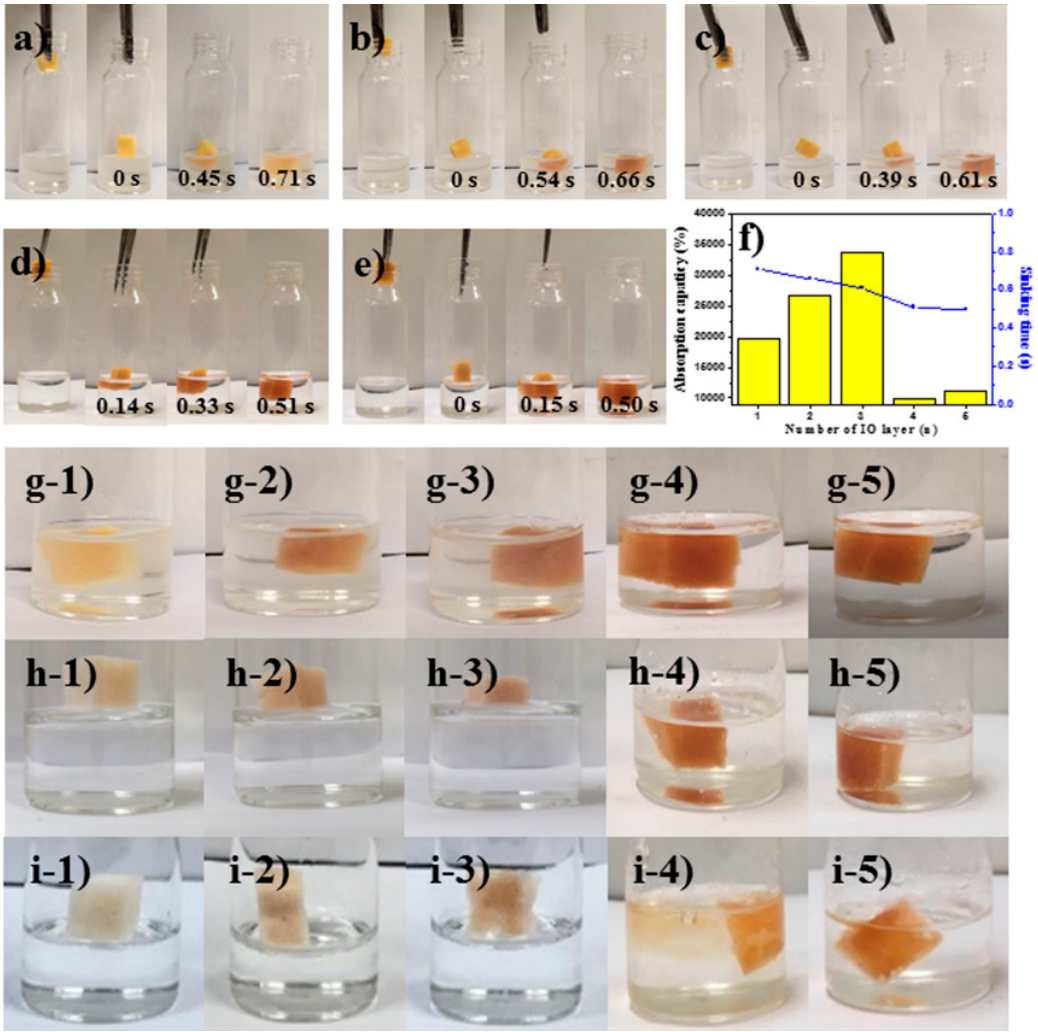
Figure 3. Drop tests of IO-coated MFS with a strong base solution (50% NaOH). ( a ) MFS/IO(1), ( b )